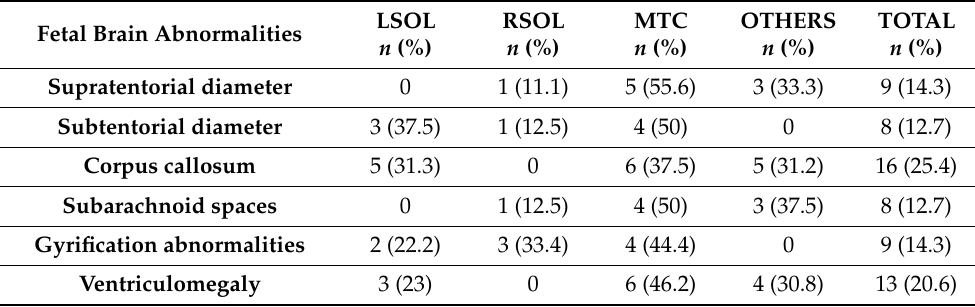
Table 3. Frequencies of brain abnormalities according to the different types of CHD, using number ( n ) and percentage (%). CHD: congenital heart disease; LSOL: left-sided obstructive lesions; RSOL: right- sided obstructive lesions; MTC: mixed type of CHD.